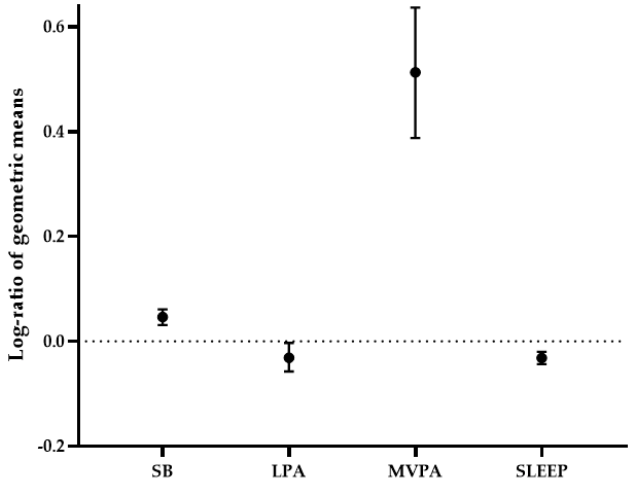
Figure 2. Log-ratio (95% confidence intervals) difference between the Scottish and South African groups for each movement behavior. Lines falling above the dotted line indicate that relative time spent in the specific behavior was higher in the Scottish cohort compared to South African cohort. Conversely, lines falling below the dotted line indicate that the component was higher in the South African sample.